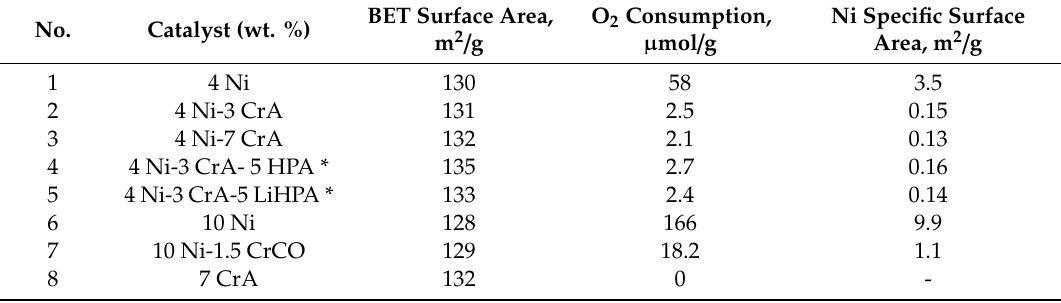
Table 1. Adsorption data for alumina supported Ni-containing catalysts of various composition.